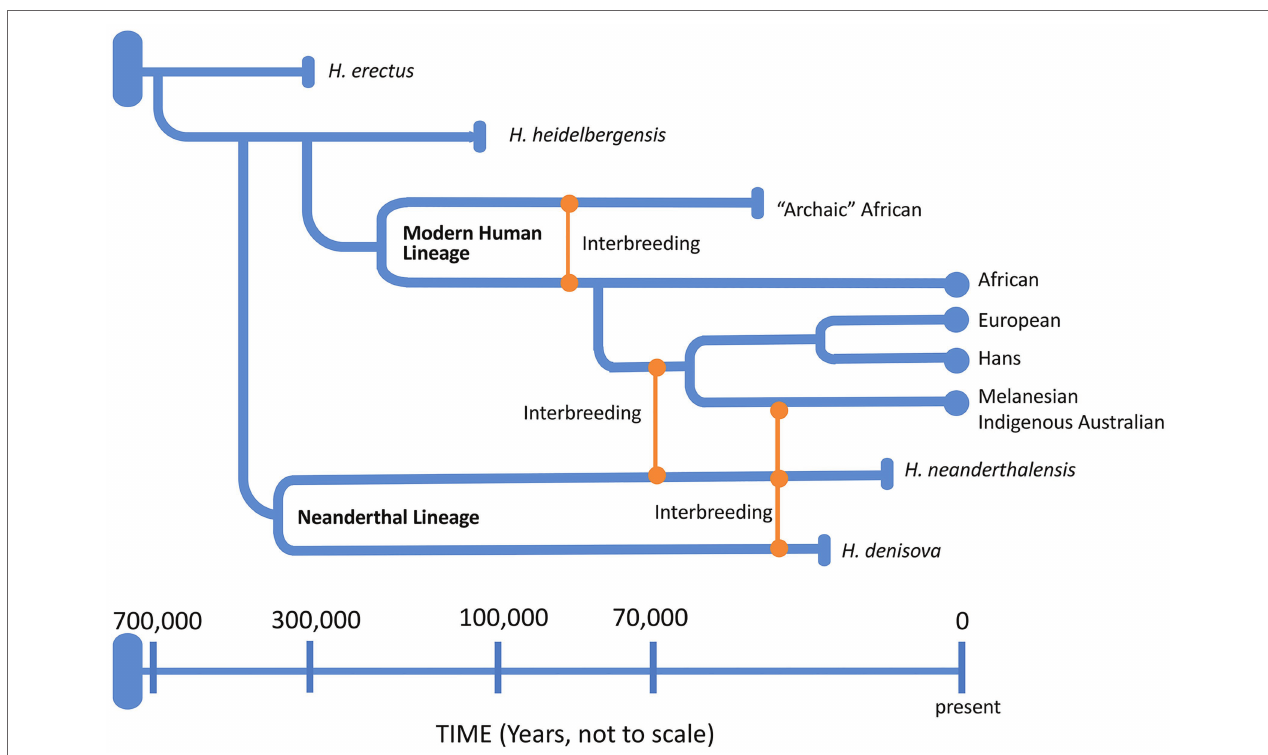
FIGURE 7 | A schematic representation of the genus Homo evolution timeline over the last 700,000 years, showing the admixture relationships between Homo sapiens , during migration out of Africa, and other archaic humans. At the end of each lineage, circle marks represent modern humans and rod marks represent archaic humans who are now